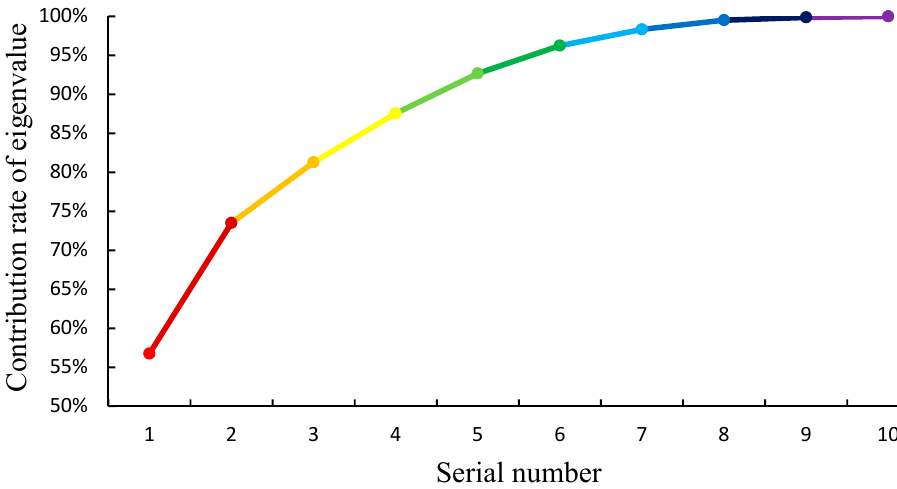
Figure 18. Contribution rates of eigenvalues.